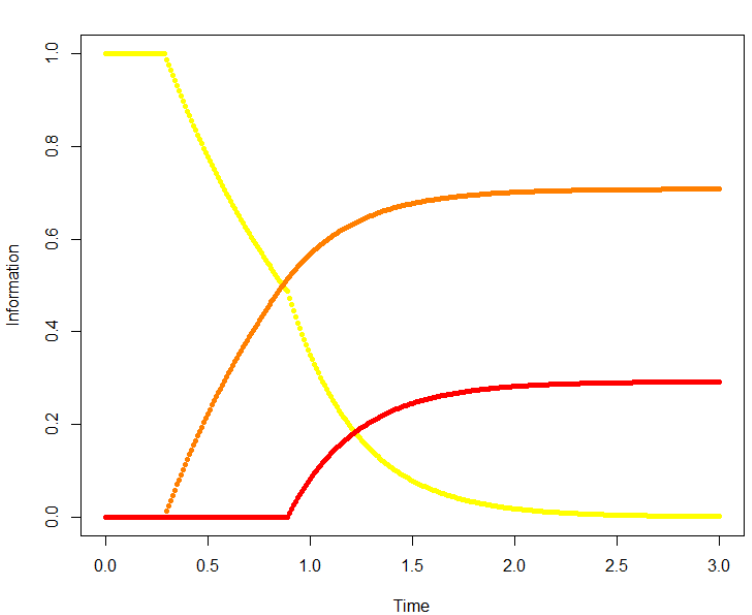
Figure 15. Same structure as in Figure 14, but with a delay τ = 0.3 for node 2 and τ (cid:48) = 0.9 for node